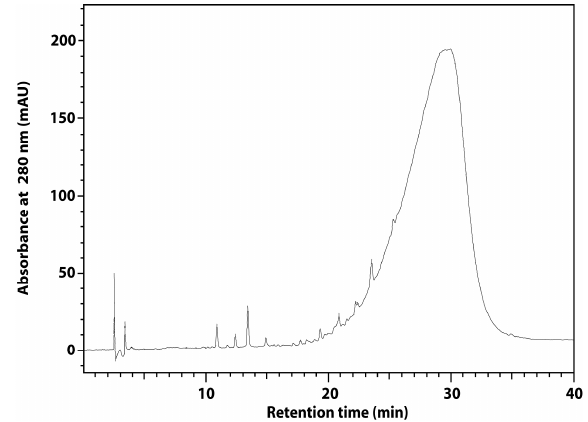
Figure 2. RP-HPLC chromatogram of flaxseed extract before hydrolysis.